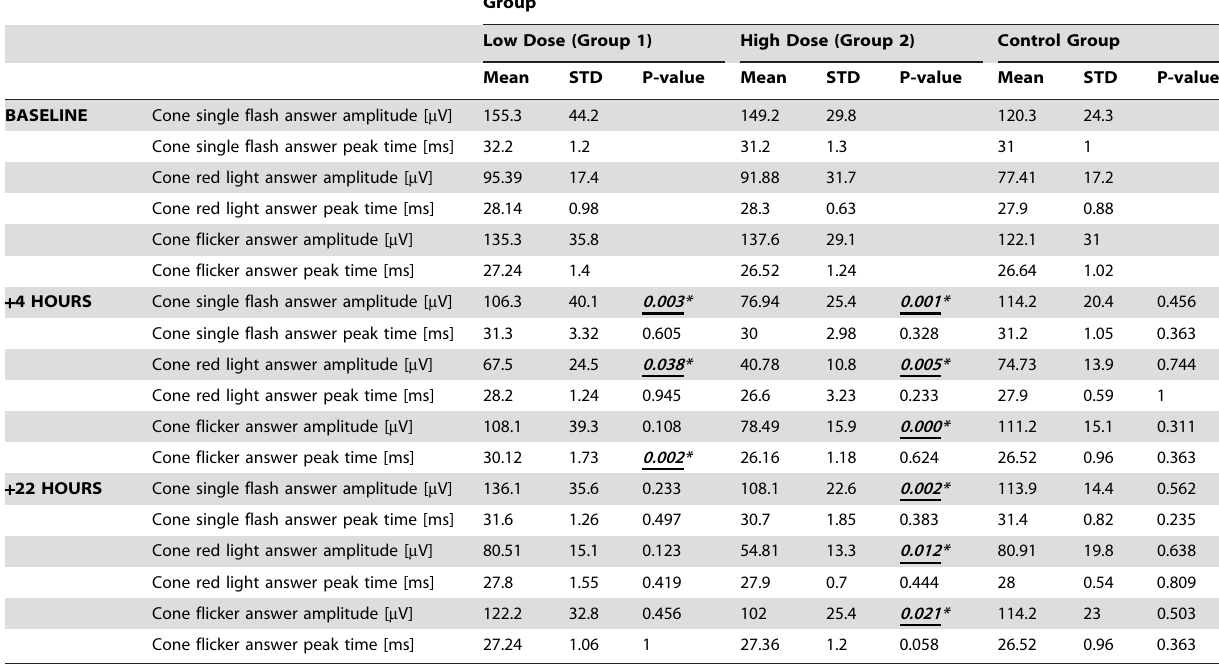
Table 6. Cone-ERG.